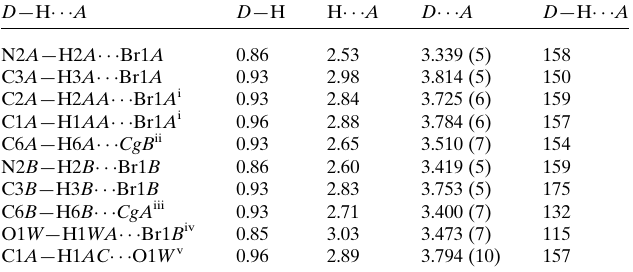
Table 2 Hydrogen-bond geometry (A˚ , (cid:5) ).